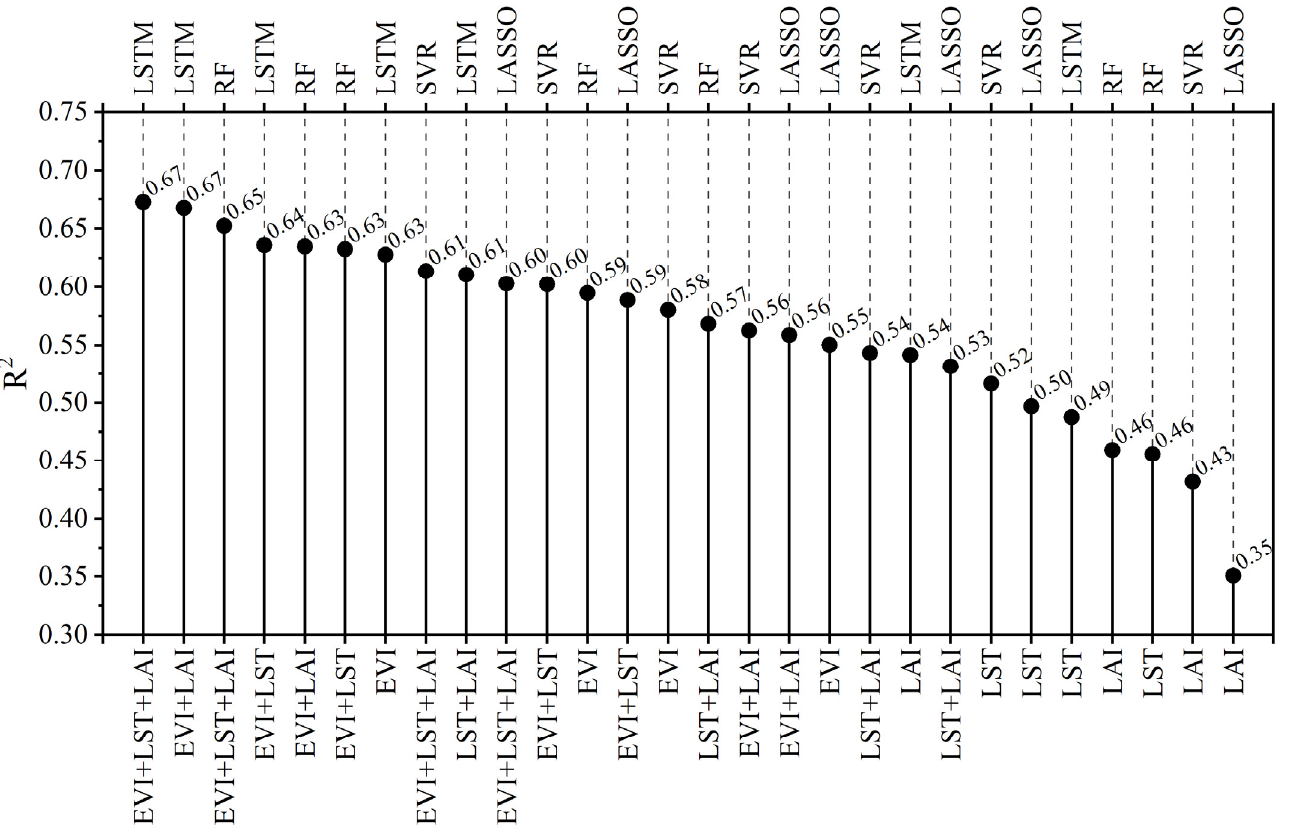
Figure 5. The ranking of model performance (predicted mean R 2 ) for the four methods using different satellite-derived index inputs for the whole growing season.